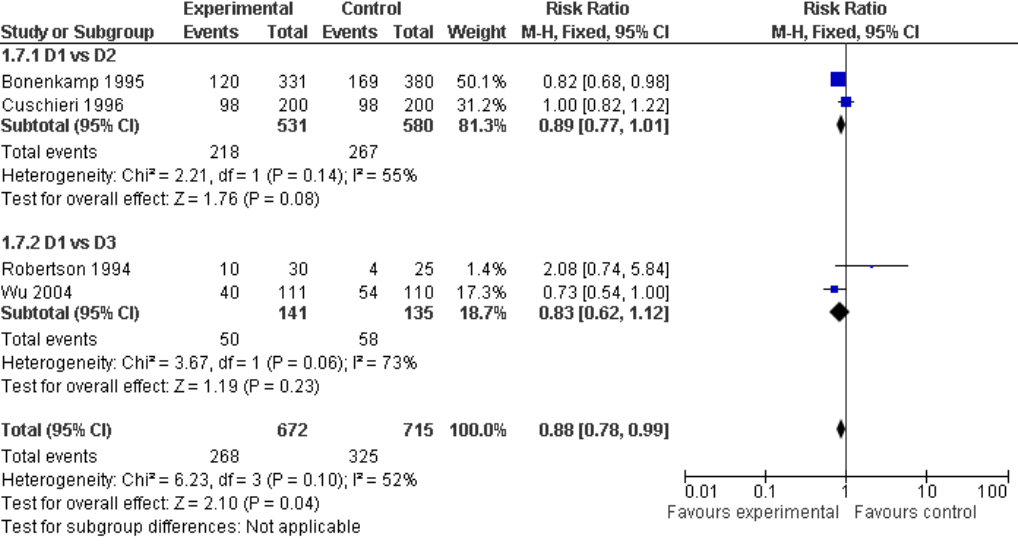
FIGURE 7 – Meta-analysis of mortality with recurrence. Effects estimates (odds ratio; 95% CI). Pooled treatment effect is shown as a diamond that spans the 95% CI. Significant statistical heterogeneity between studies results. Overall effect with statistically significant difference favoring D2 or D3 lymphadenectomy (p=0.04)